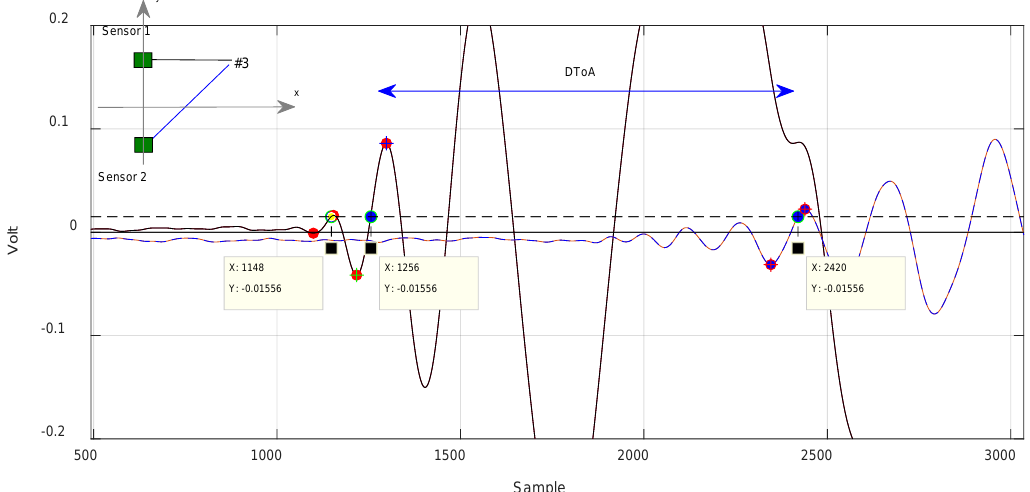
Figure 12. Impact case in position #3, signal received from the sensors sensor 1 and sensor 2. Evaluation method of the DToA with likelihood algorithm. Ts = 1 × 10 − 7 s.